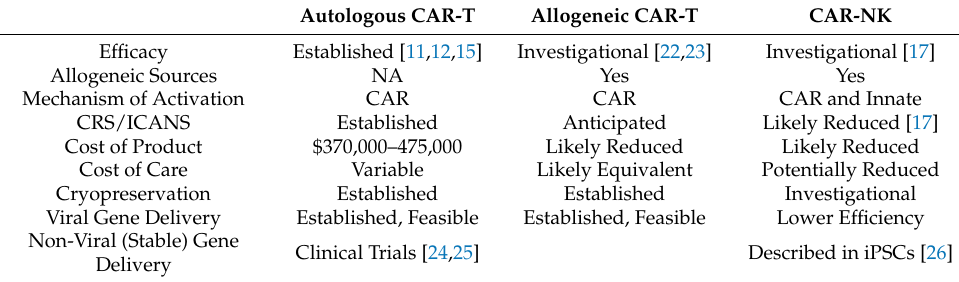
Table 1. Comparing the characteristics of CAR-NK to autologous and allogeneic CAR-T therapies. iPSC = induced pluripotent stem cell, CRS = cytokine release syndrome, ICANS = immune effector cell-associated neurotoxicity